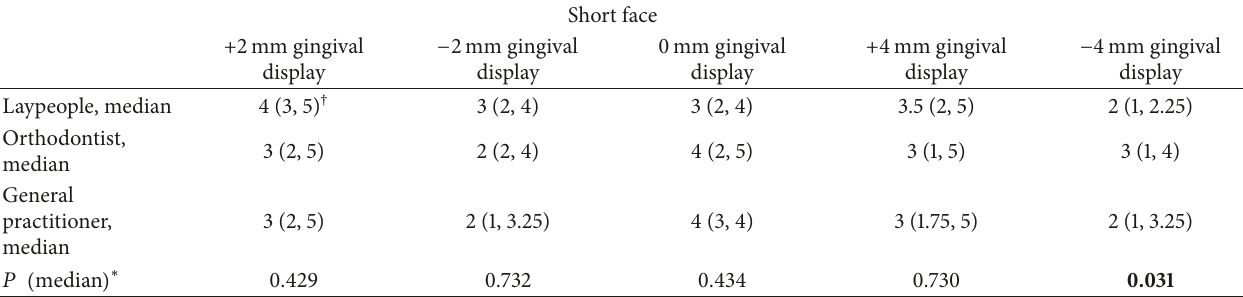
Table 2: Comparison of median scores given by laypeople, orthodontists, and general practitioner dentists for short faces. Short face − 2 mm gingival − 4mm +2 mm gingival 0mm gingival +4mm gingival display display display display